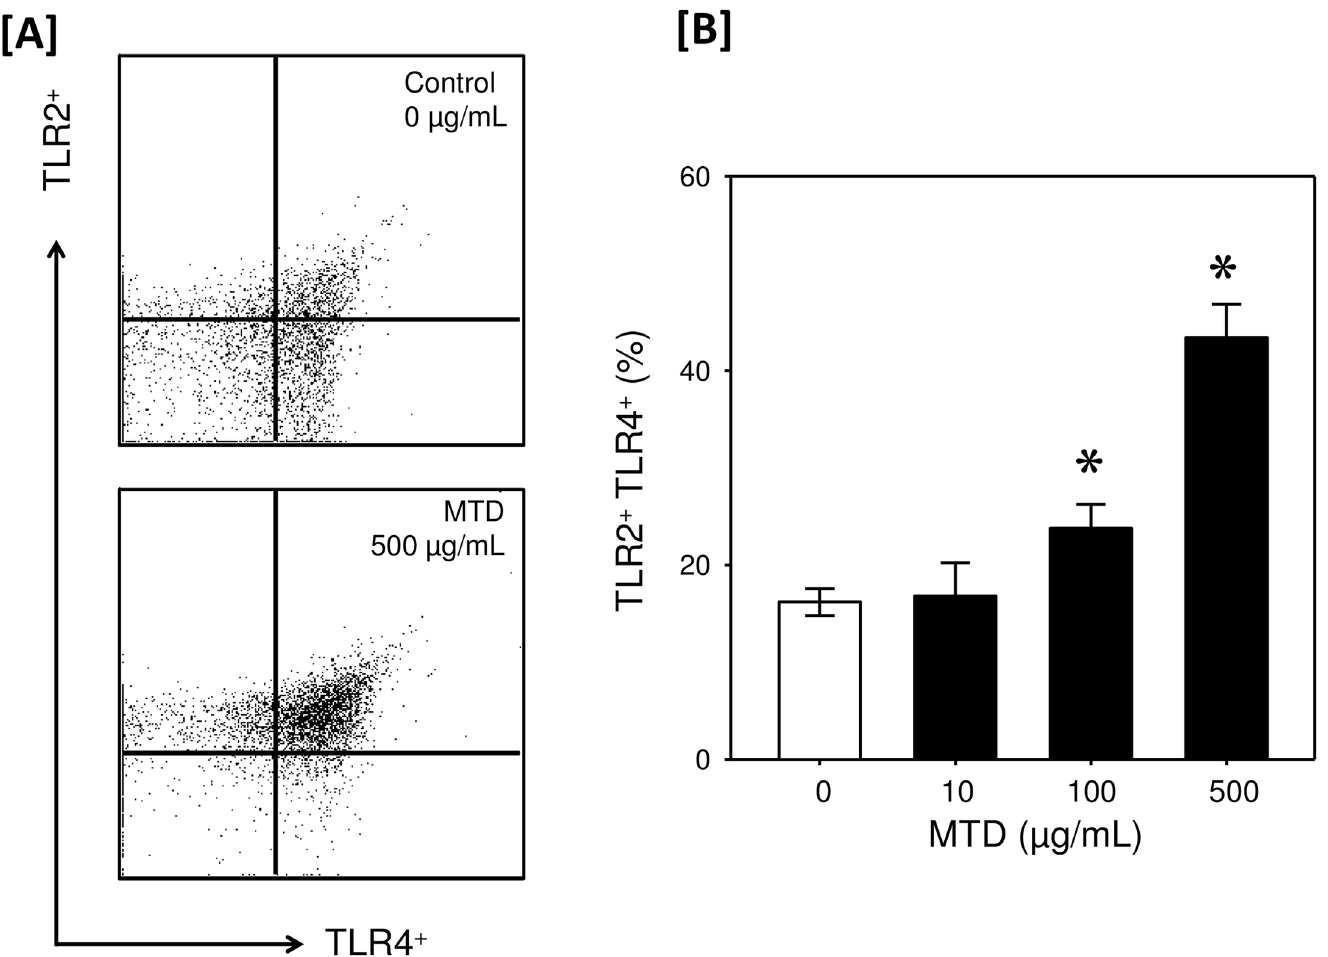
Fig 4. MTDs increase co-expression of TLR2 and TLR4 by dermal γδ T-cells. Skin T-cells were incubated with MTDs (0 – 500 μ g/mL) and TLR2 and TLR4 co-expression on the γδ T-cell population was determined by flow cytometry as described in the materials and methods. Panel A shows a representative scatter plot for TLR2 and TLR4 expression on dermal γδ T-cells under control conditions and following stimulation with 500 μ g/mL MTDs. Panel B shows the percentage of γδ T-cells positive for both TLR2 and TLR4. Data are Mean ± SEM for cells from 5 mice. * p < 0.05 as compared with control (0 μ